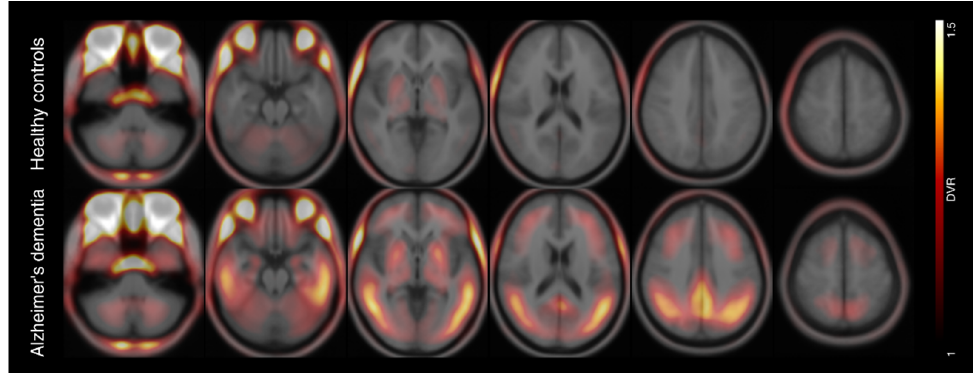
Figure 3. Mean parametric 18 F-PI-2620 PET distribution volume ratio (DVR) images of healthy controls (top row) and patients with Alzheimer’s dementia (bottom row) overlayed on an averaged anatomical MRI scan in standard space of the Montreal Neurological Institute (MNI).